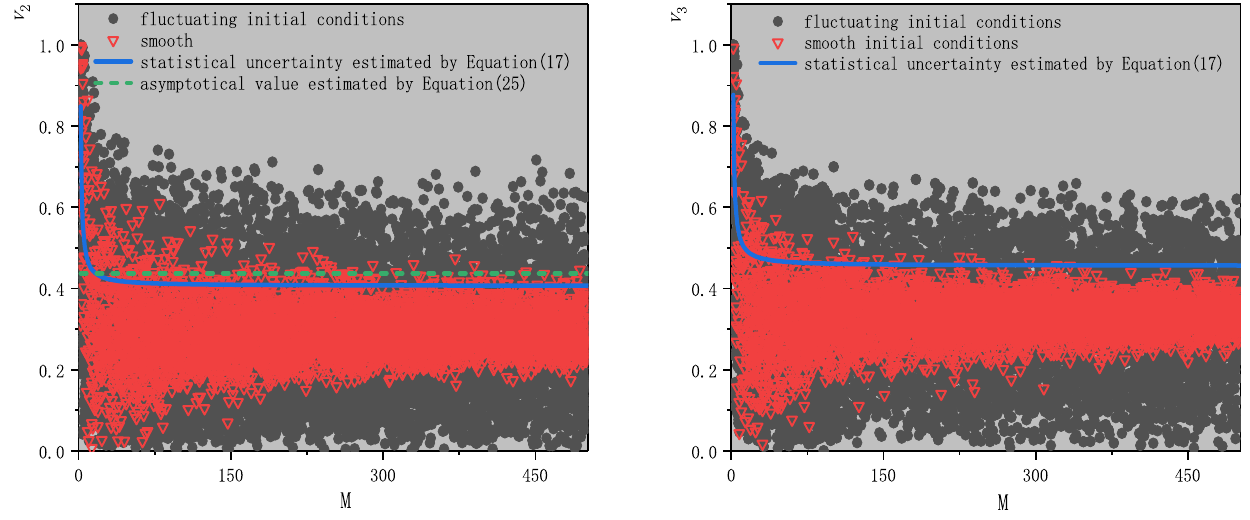
Figure 1. The extracted elliptic and triangular flow coefficients for the events of smooth and fluctu- ating initial conditions, as a function of multiplicity per event M for N = 10. The values of v 2 are (cid:113) (cid:99) v 2 n given by Equation (22). The hollow red triangles represent the results obtained estimated using by the smooth initial condition, and the filled black circles are those by the identical point-source model. The solid blue curve estimates the statistical uncertainties using Equation (17). The dashed green curve shows the asymptotical value of the square root of the variance given by Equation (25) due to event-by-event